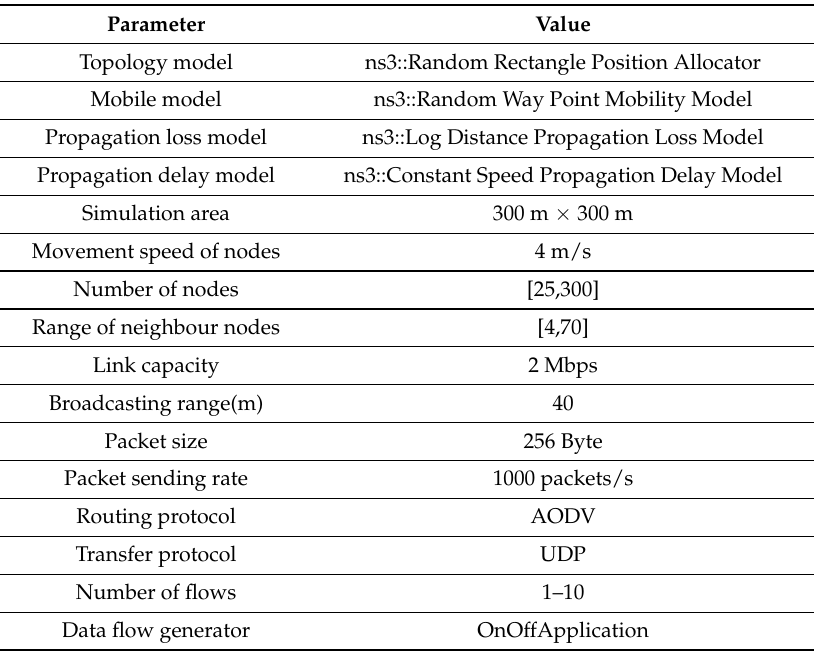
Table 3. Simulation